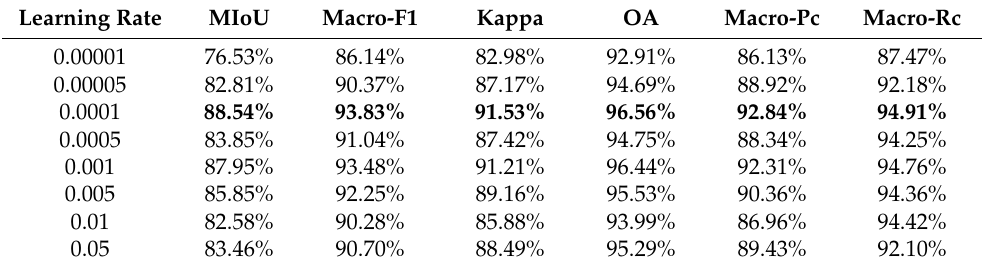
Table 8. Quantitative evaluation results of CSD-Net with different learning rates.